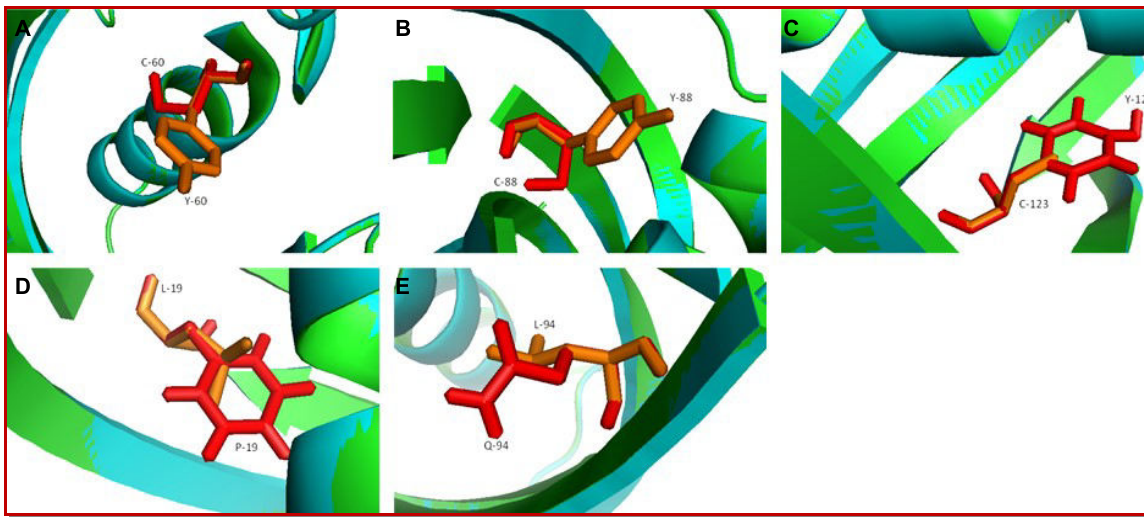
Figure 1: Superimposed view of C60Y (A), Y88C (B), C123Y(C), L19P (D) and L94Q (E) rendered using